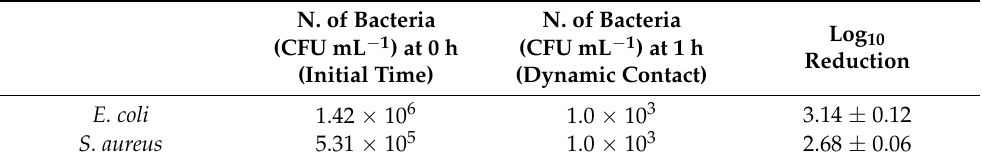
Three log reduction means a 99.9% kill of the bacteria.